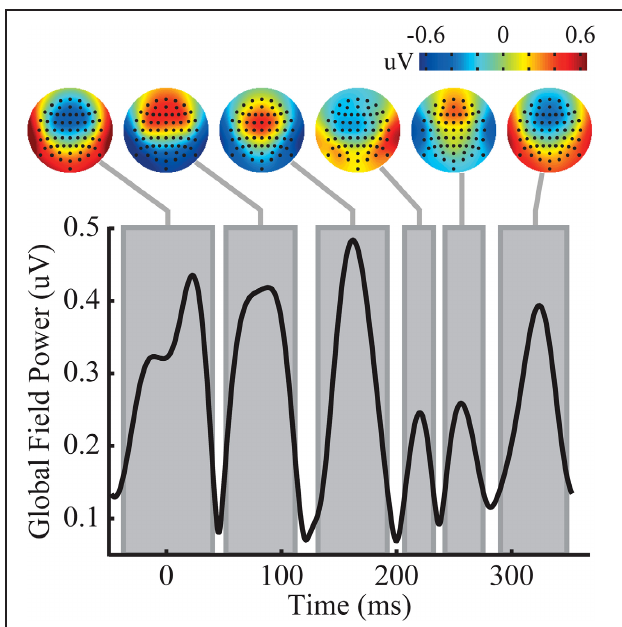
FIGURE 3 | Analysis of the triplet epoch reveals six time windows with distinct topography. The temporal evolution of global field power (GFP) is shown on the y-axis. Each gray box represents the time window of a distinct topography shown above. See the main text for exact specifications of the time